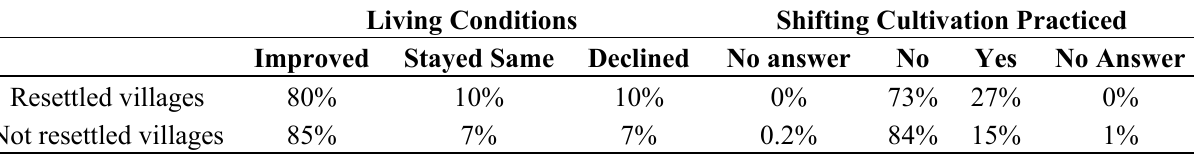
Figure 2. New site location of resettled villages between 2000 and 2011 in Laos. Table 3. Living conditions and presence of shifting cultivation practices in resettled and non-resettled